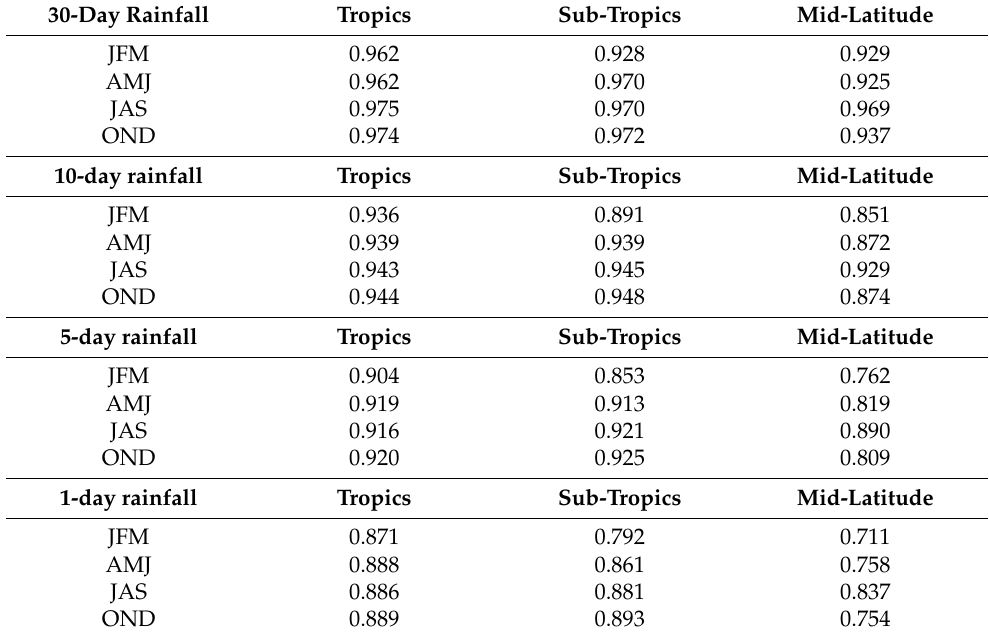
Table 1. The mean correlation coefficients between IRQPE and CMORPH2 for 3 latitudinal bands and 4-time scales in 4 seasons based on the period of 2018–2021. The 3 latitudinal bands are